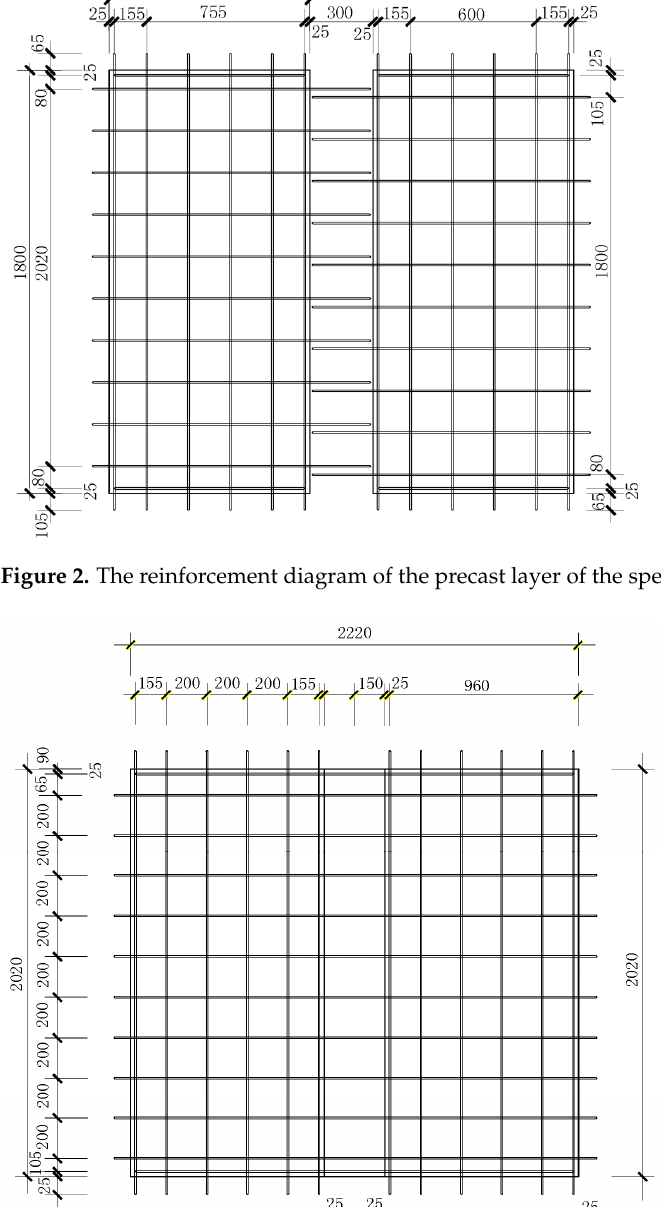
Figure 1. CAD model dimension of CLHCPCS 1.